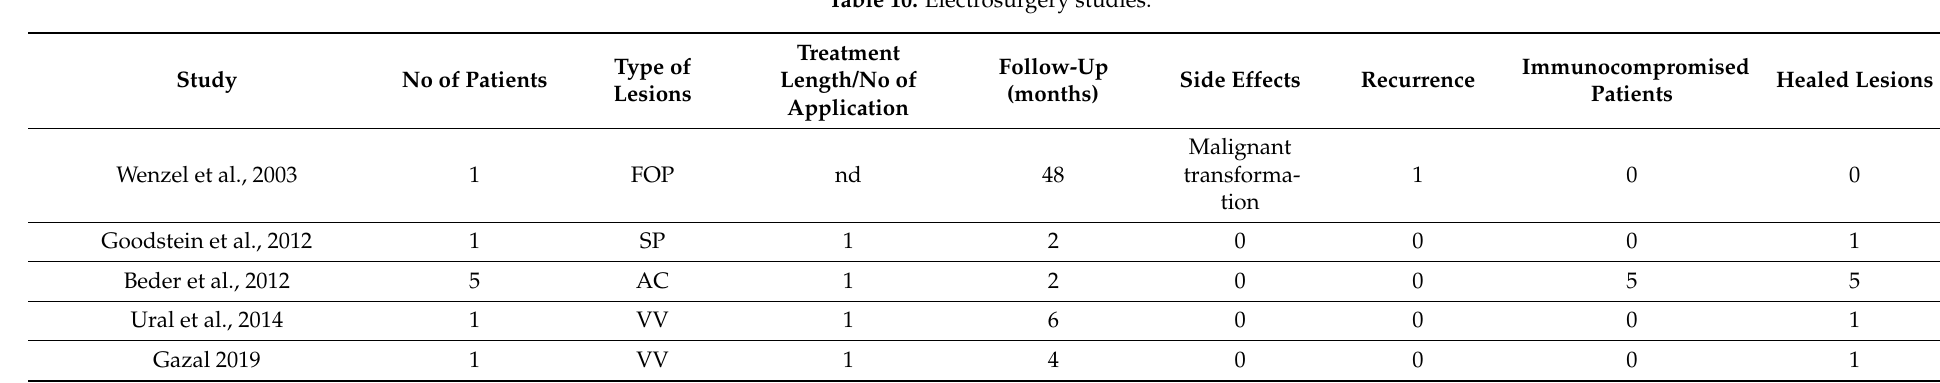
Table 10. Electrosurgery